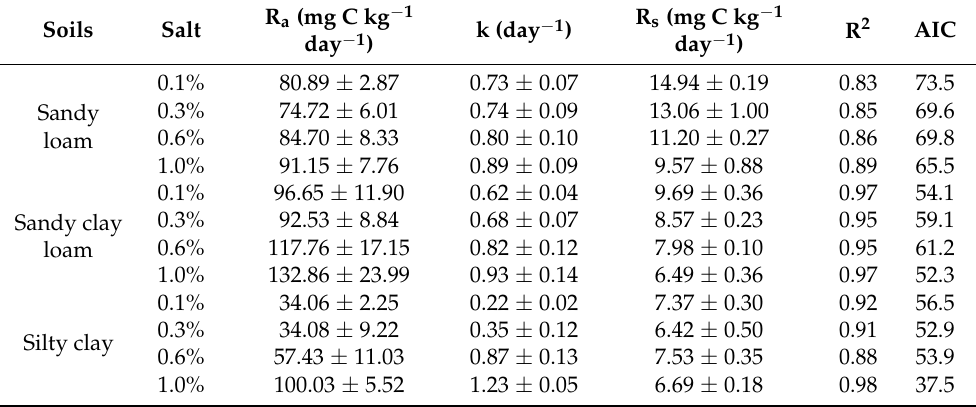
Table 5. The simulated values of initial decomposition rate ( R a ) and decay rate constant ( k ) of the active carbon pool and decomposition rate of stable carbon pool ( R s ) based on the two-compartment kinetic model for the three soils. AIC denote Akaike’s information criterion